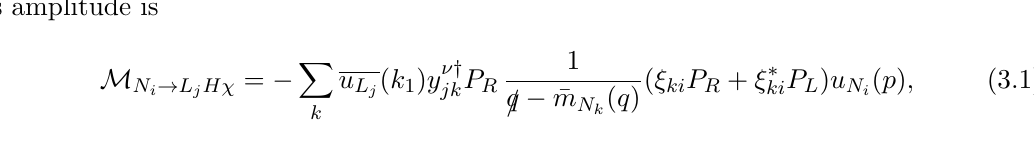
The total CP asymmetry from two-body decay of the lightest and heavier RH neutrinos are given